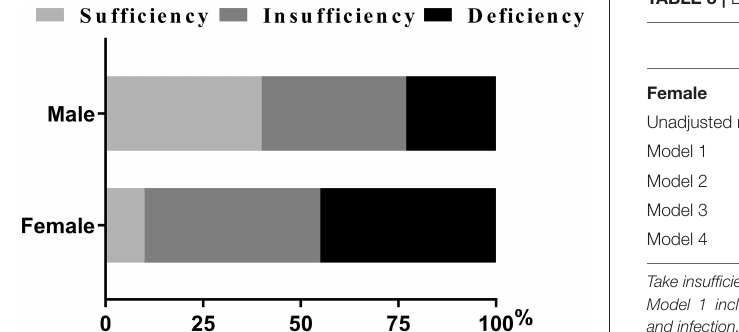
TABLE 3 | Binary logistic models to examine the effect of gender on